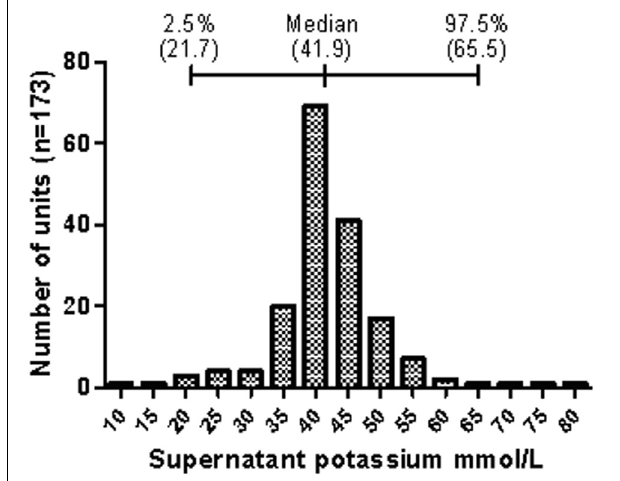
FIGURE 4 | Distribution of supernatant potassium concentration of stored donor red cell units. The graph shows the distribution of the potassium concentration in the supernatant of red cell units at day 35 of refrigerated storage as collected by the Components Development Laboratory, NHSBT. Data represents randomly selected units collected between 2003 and 2006. The median and median percentile data are shown above the bar chart. Reprinted from Bawazir et al. (in press), with